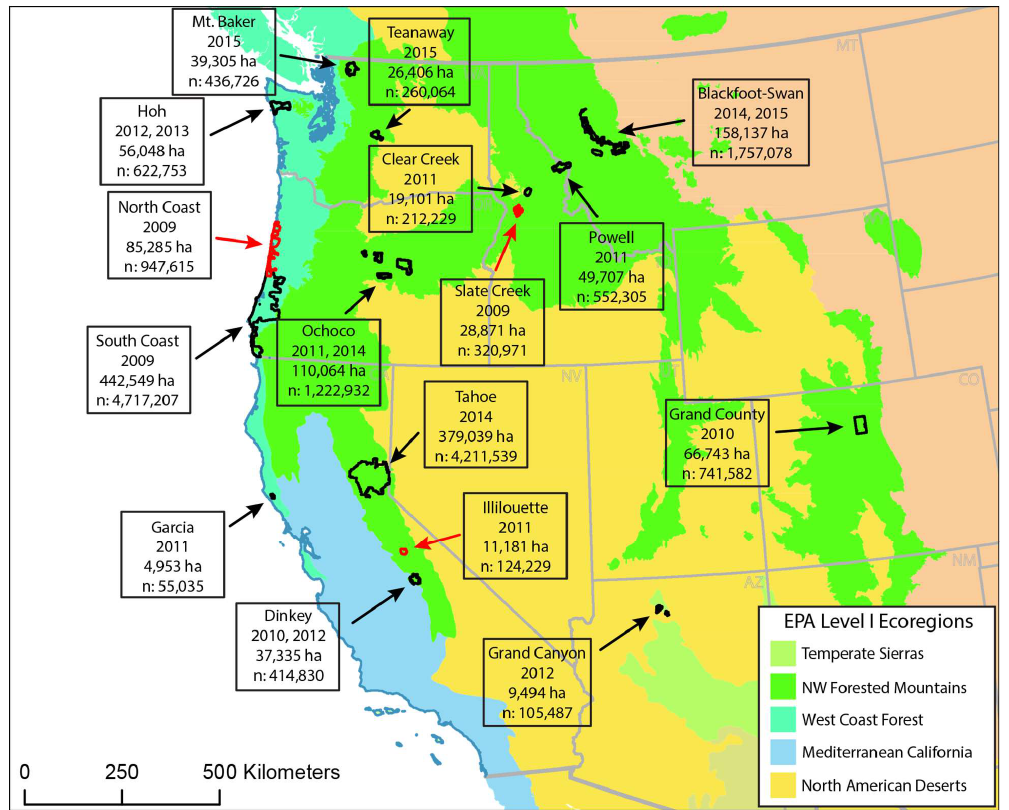
Figure 1. Map showing the spatial distribution of light detection and ranging (LiDAR) datasets in the western United States with information on the year of acquisition, area of data used after filtering, and number of samples in each dataset. Black perimeters show landscapes where training, validation, and testing data were used while red perimeters show landscapes used exclusively for testing (North Coast, Illilouette, and Slate Creek landscapes).